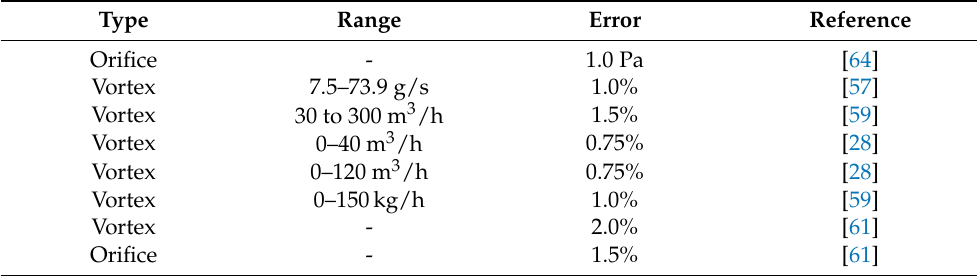
Table 19. Devices used in steam flow